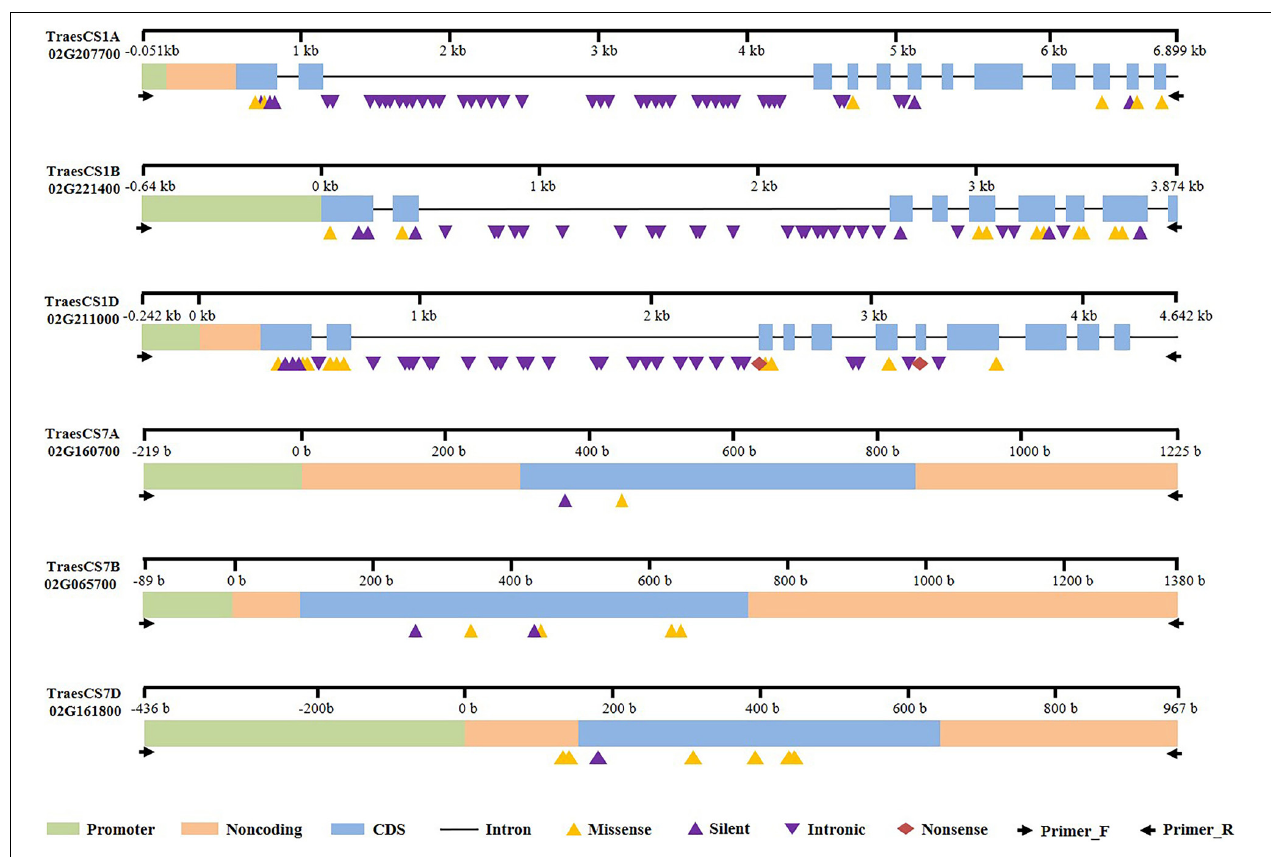
FIGURE 3 | SNP distribution in the six target fragments of Bsr-k1 and Bsr-d1 wheat